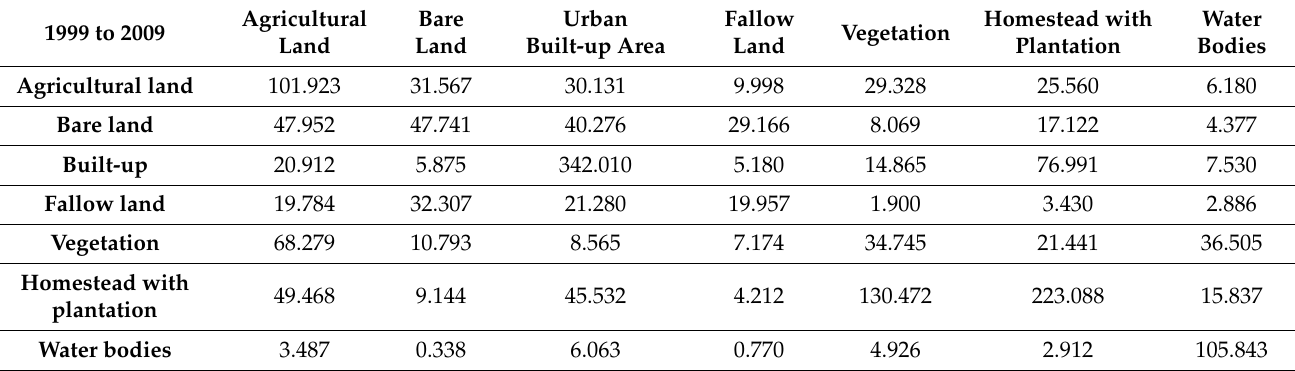
Table 15. Transition matrix (1999 to